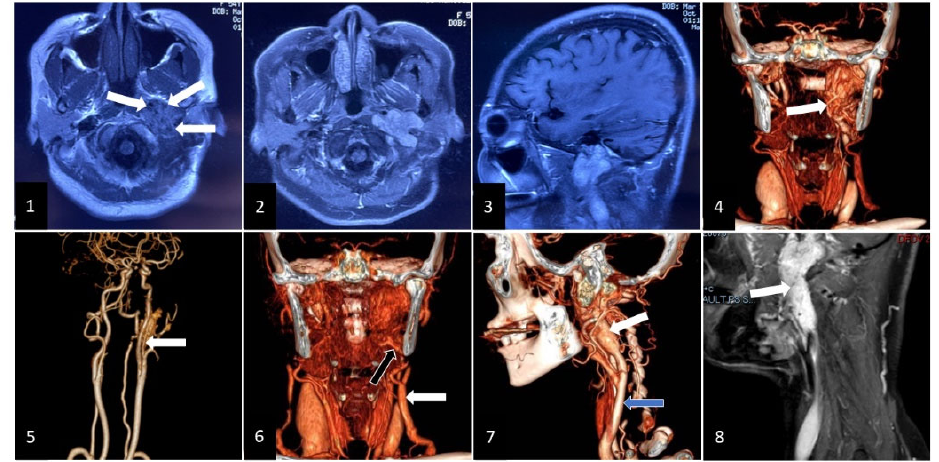
Figure 3. Images show radiographic results of the extracranial lesion. ( 1 ): showing the mass lesion with vascular flow void in left jugular foramen. White arrow: tumor with vascular flow void; ( 2 ) and ( 3 ): displaying the enlarged extracranial lesion on CE-MRI; ( 4 ) and ( 5 ): showing the feeding arteries from the external carotid artery on computed tomography angiography. White arrow: feeding arteries; ( 6 ): displaying the draining veins flowing into the external jugular vein. White arrow: external jugular vein. Black arrow: draining vein; ( 7 ): extracranial lesion being closely associated with internal jugular vein. White arrow: extracranial tumor. Blue arrow: internal jugular vein; ( 8 ): displaying the internal jugular vein with occlusion. White arrow: extracranial lesion and occluded internal jugular vein.